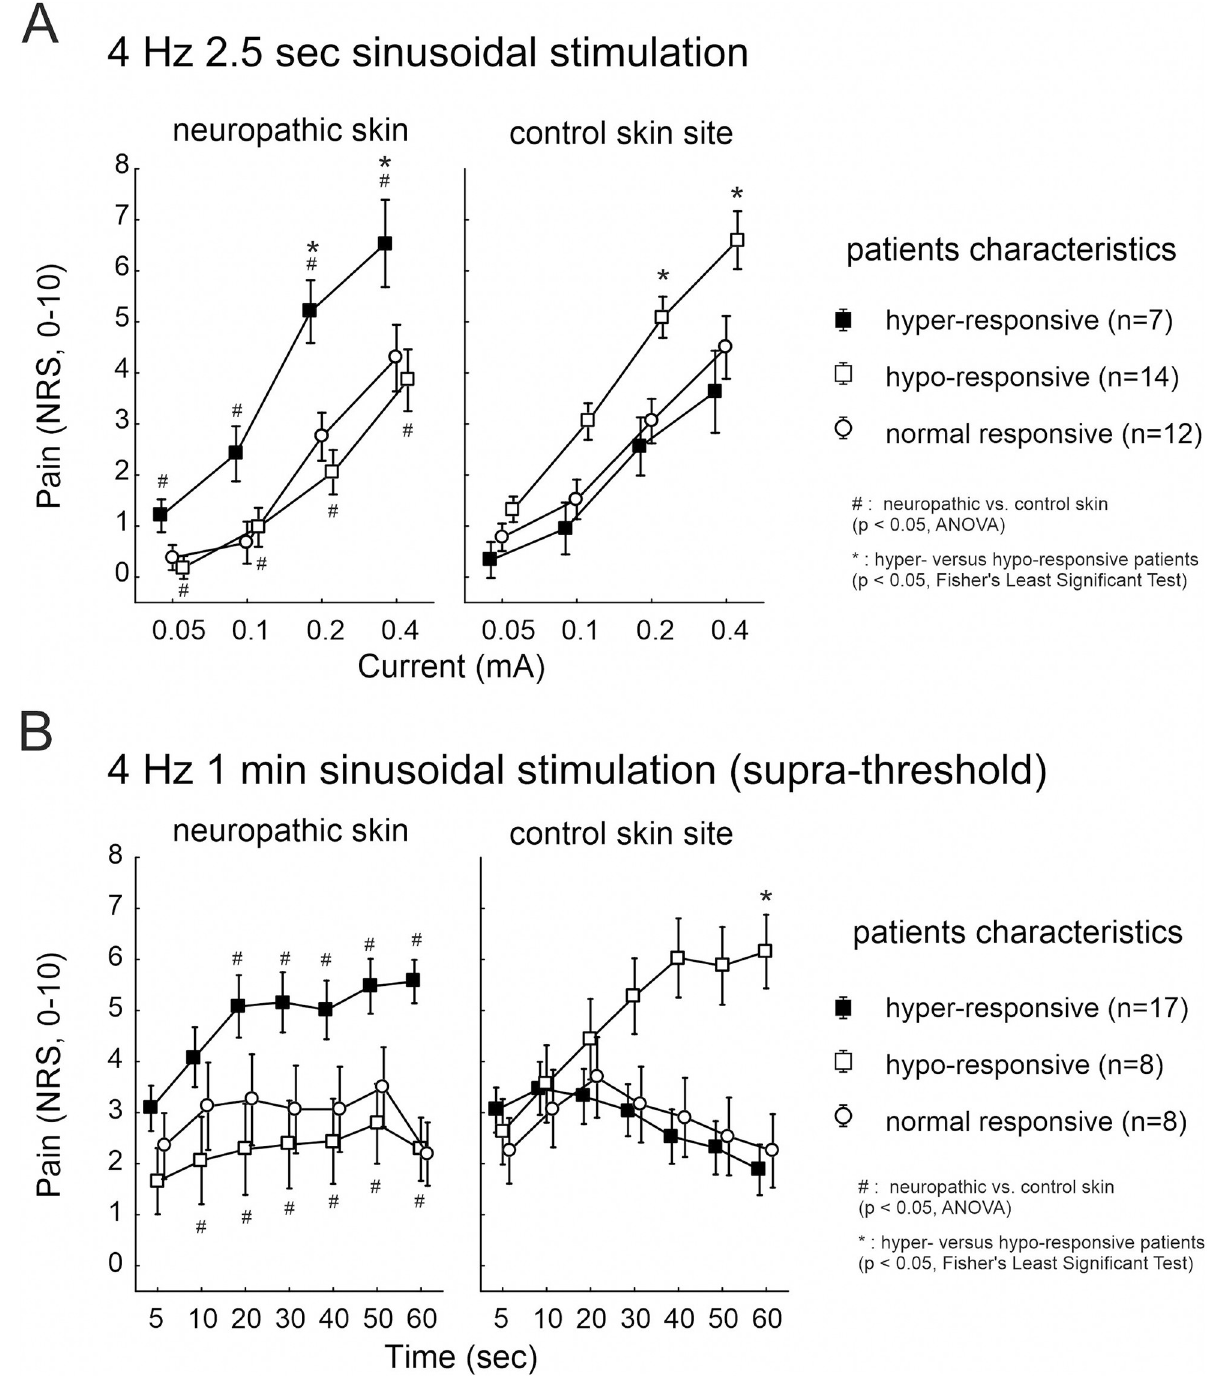
Fig 2. Pain upon 4 Hz sinusoidal pulses. Electrically evoked pain (NRS, 0–10) recorded from the neuropathic (left panel) and control (right panel) skin sites upon (A) 2.5 sec 4 Hz sinusoidal pulses of 0.05 to 0.4 mA (n = 33), and (B) continuous 1 min 4 Hz sinusoidal pulses of supra-threshold intensity (n = 33). Patients that reported increased pain at neuropathic compared to control skin sites upon stimulation (delta NRS > 1) were grouped “hyper-responsive” (solid squares), patients with less sensitivity (delta NRS < -1) “hypo-responsive” (open squares), and patients without NRS differences between the sites (delta NRS < 1and > -1) classified “normal” (open circles). Hash symbols indicate significant differences between neuropathic and control skin (p < 0.05, ANOVA), asterisks indicate significant post-hoc comparisons between the patients’ groups (p < 0.05, Fisher’s Least Significant